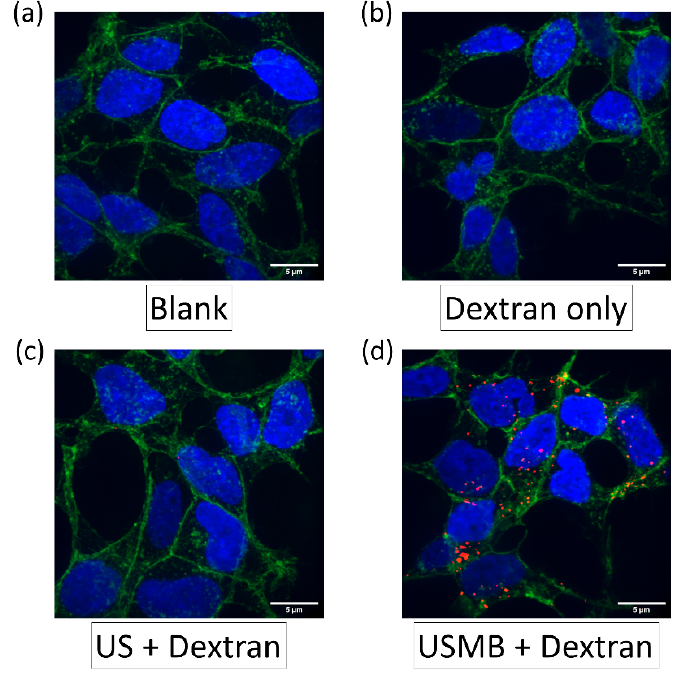
Figure 4. Representative confocal images of HEK293 cells. ( a ) Confocal image of ‘Blank’ control group. The ‘Blank’ control represents cells exposed to PBS solution alone. Blue represents ‘DAPI’ used to stain cell nucleus, green represents wheat germ agglutinin tagged with AF-488. ( b ) Confocal image of ‘Dextran only’ control group. The ‘Dextran only’ control represents cells exposed to a solution of 70 kDa dextran in PBS. ( c ) Confocal image of ‘US + Dextran’ control group. The ‘US + Dextran’ control represents cells exposed to a solution of 70 kDa dextran in PBS, along with ultrasound treatment. ( d ) Confocal image of ‘USMB + Dextran’ control group. The ‘USMB + Dextran’ control represents cells exposed to a solution of 70 kDa dextran and microbubbles in PBS, along with ultrasound treatment. Red in the image indicates 70 kDa dextran tagged with tetramethylrhodamine.